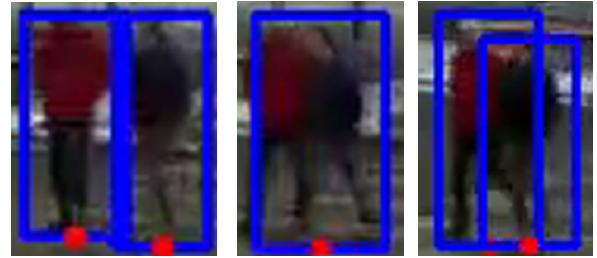
Figure 11. Pedestrian group detection